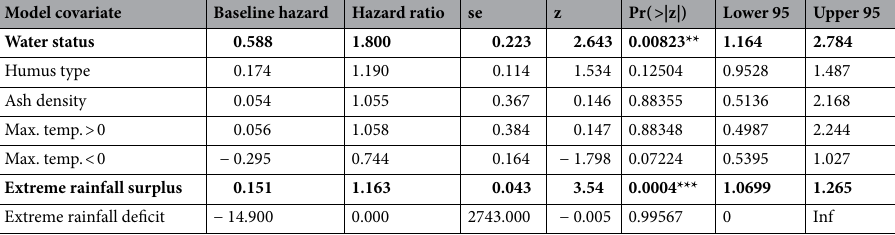
Model covariate Baseline hazard Hazard ratio se